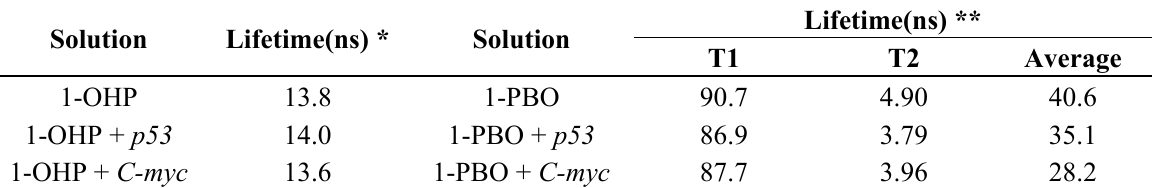
Table 4. The calculated lifetime of pyrene derivatives in the absence and presence of DNA.